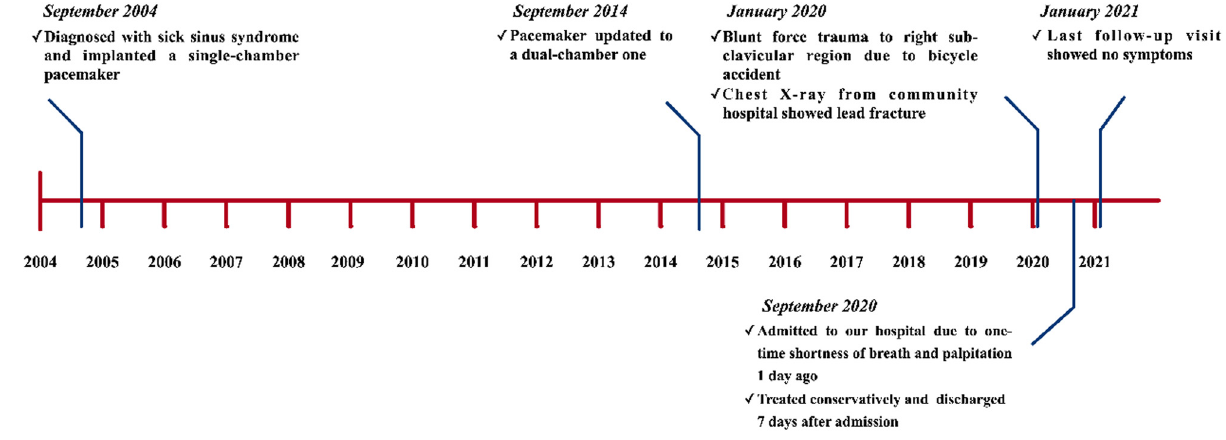
Figure 1: Case timeline.